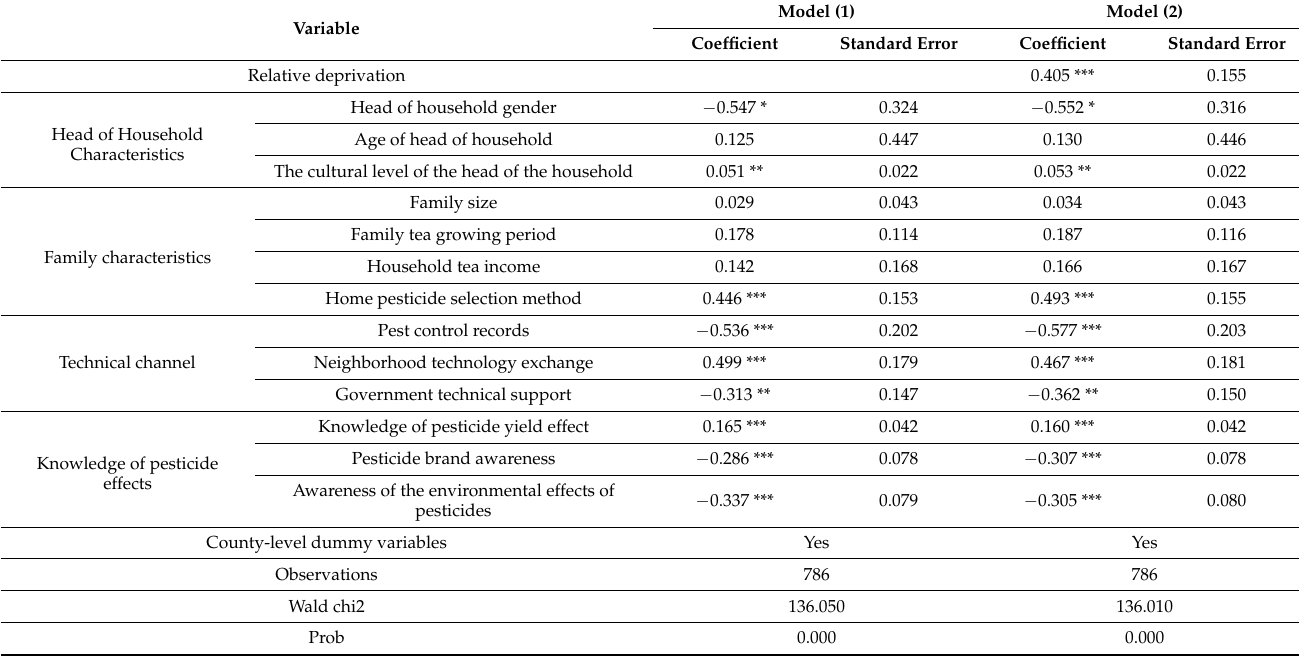
Table 2. Factors of importance for the pesticide application rate by tea